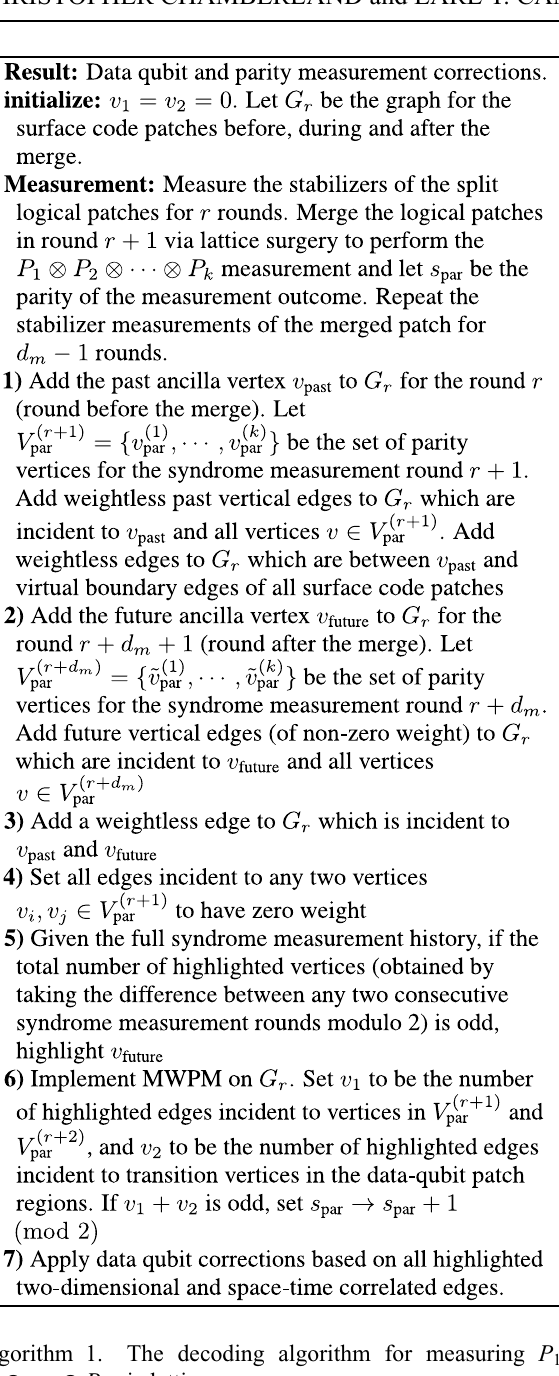
Algorithm 1. The decoding algorithm for measuring P 1 ⊗ P 2 ⊗ · · · ⊗ P k via lattice